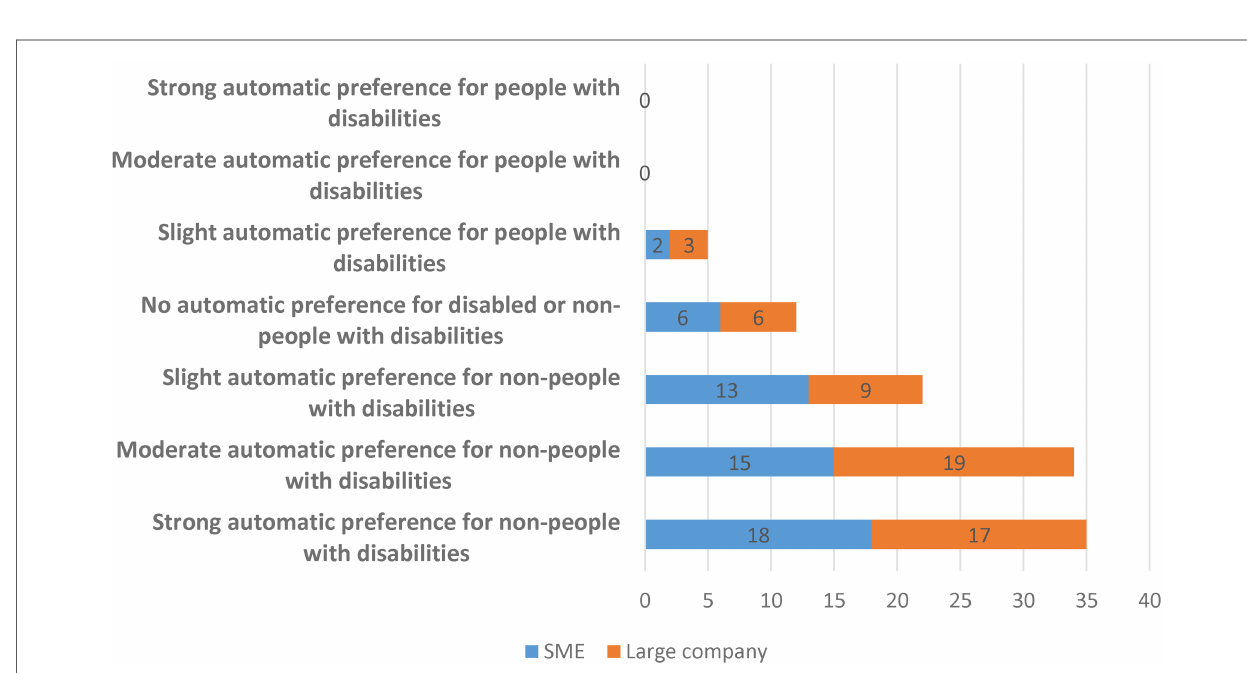
FIGURE 3 Distribution of IAT scores categorised by whether someone works for an SME or a large company ( N